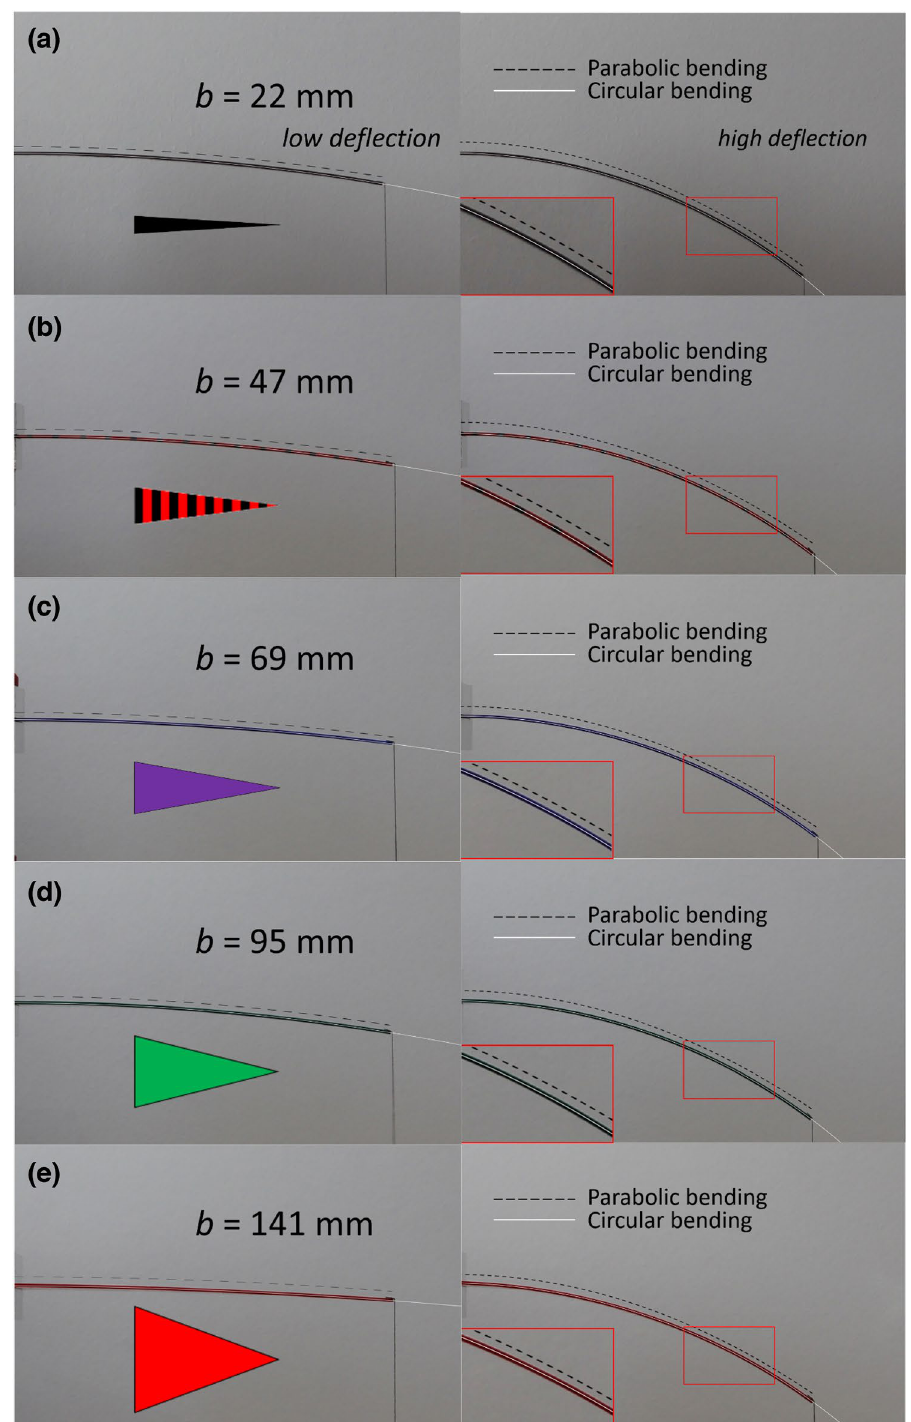
Figure 11. Bending of triangular cantilevers in high deflection. The base widths b are 22 mm, 47 mm, 69 mm, 95 mm, and 141 mm. The length of the cantilevers L is 190 mm the thickness t is 1.5 mm. The dashed black curve shows the solution of the EB equation, the white curves show circular arcs. The insets on right-had photos (high deflection) show a zoom illustrating a circular arc fit (white line) and the parabolic bending model (dashed black